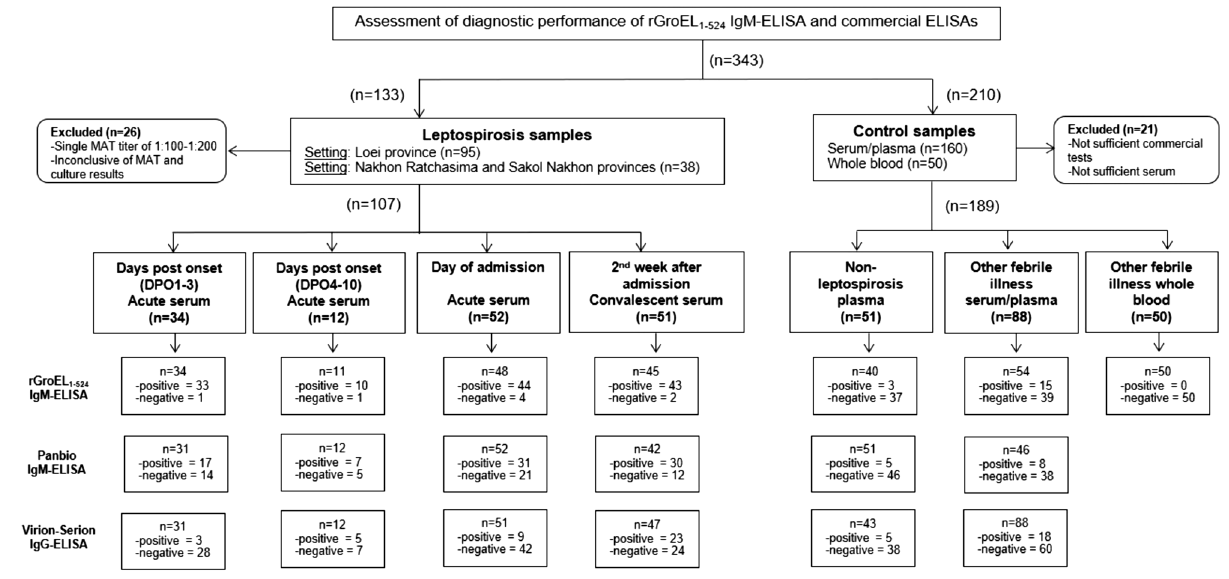
Figure 2. Flow diagram of the assessment of diagnostic accuracy of rGroEL 1-524 IgM-ELISA, and commercial ELISAs. Confirmed leptospirosis sera (n = 133) and control samples (n = 210) were subjected to an